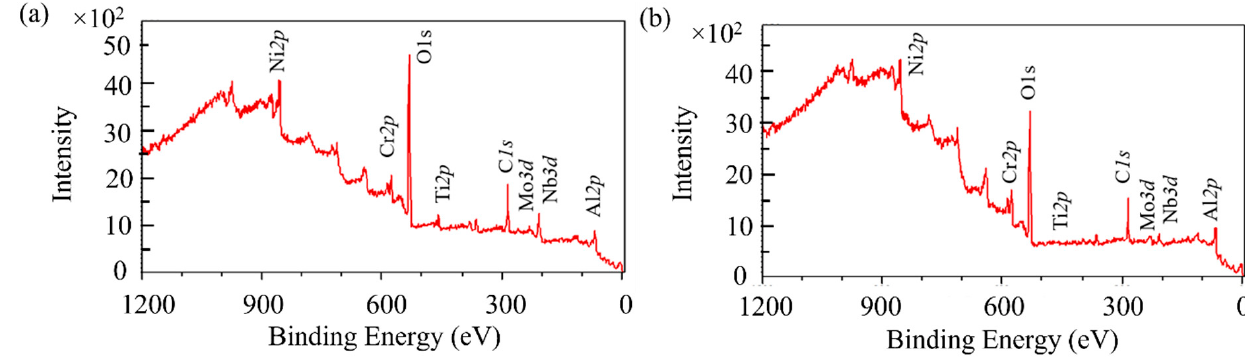
Figure 6. X-ray photoelectron spectroscopy (XPS) survey spectra of Inconel 718 PA powders: ( a ) Virgin powder; ( b ) Ball- milled (30 min) powder.